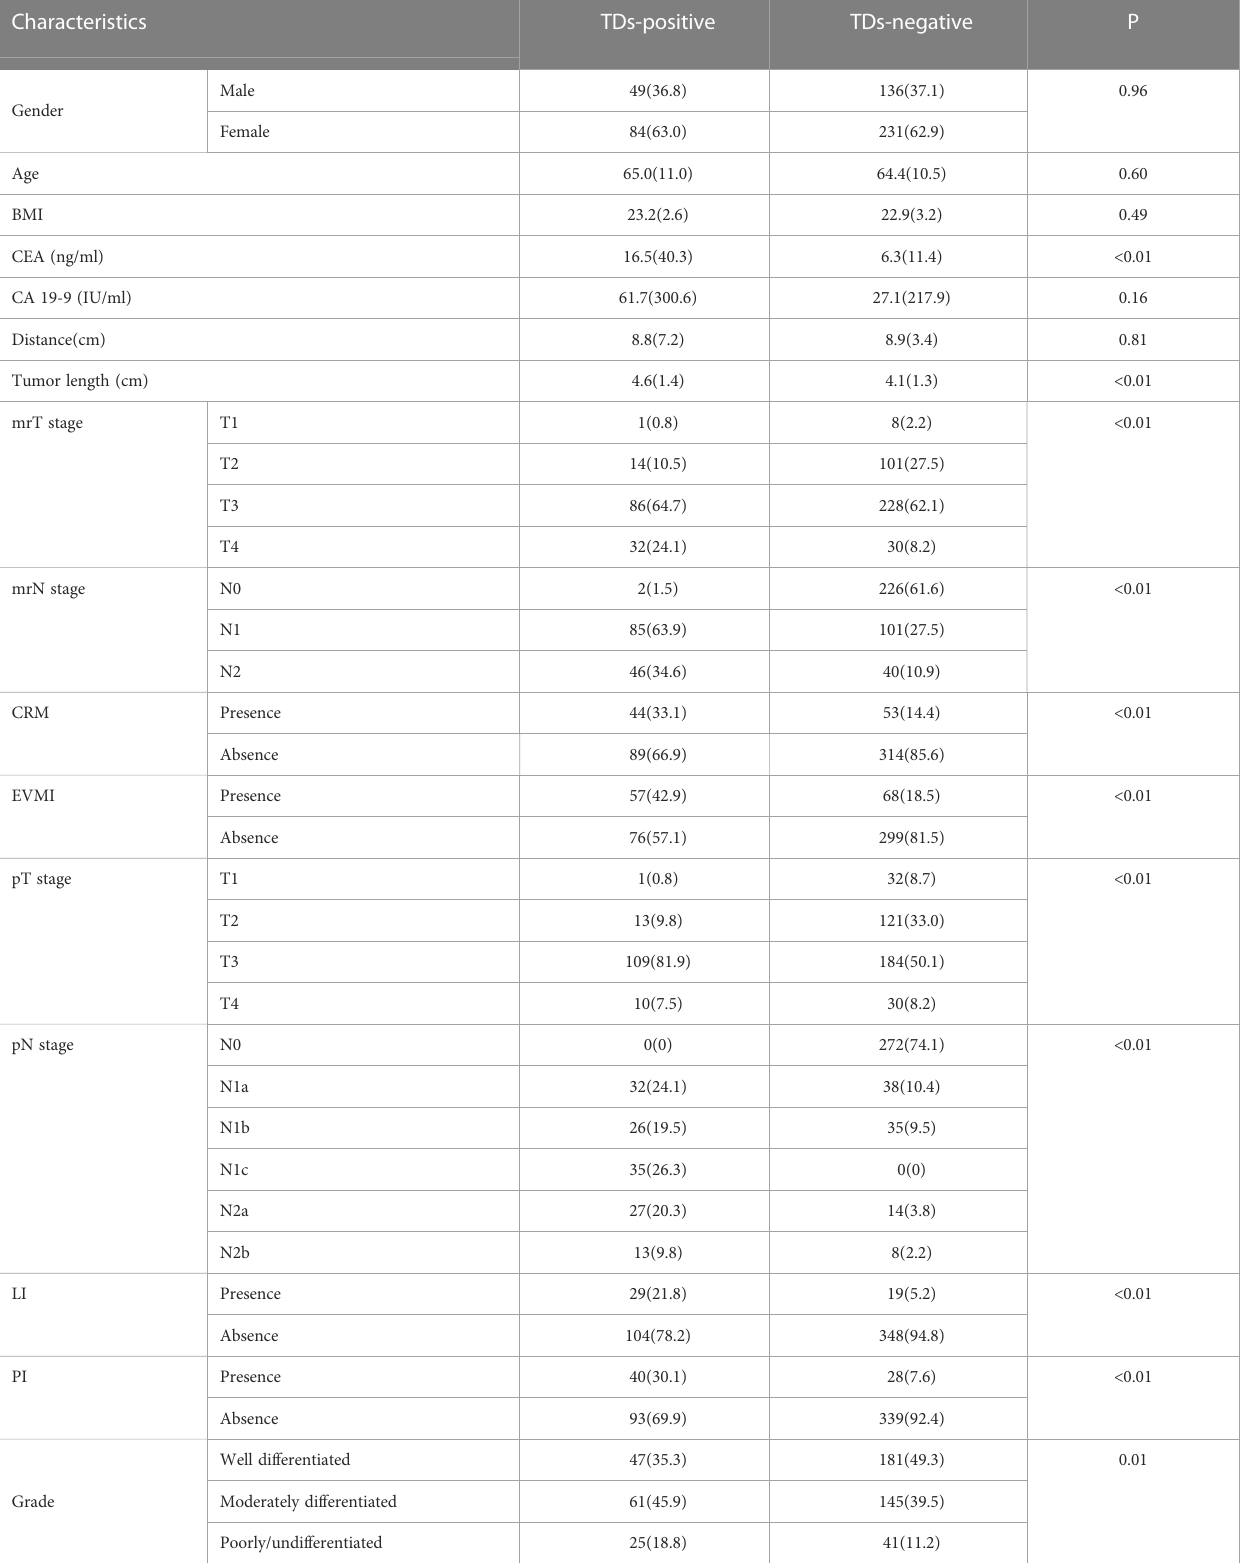
TABLE 2 The baseline characteristics of the